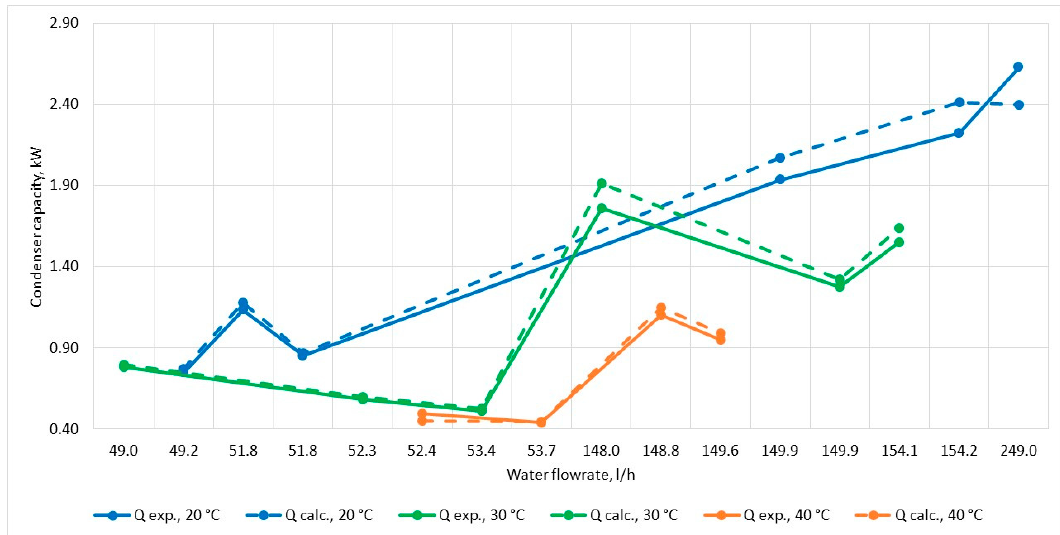
Figure 2. Experimental and calculated fog unit capacities depending on water flows and inlet water temperatures.